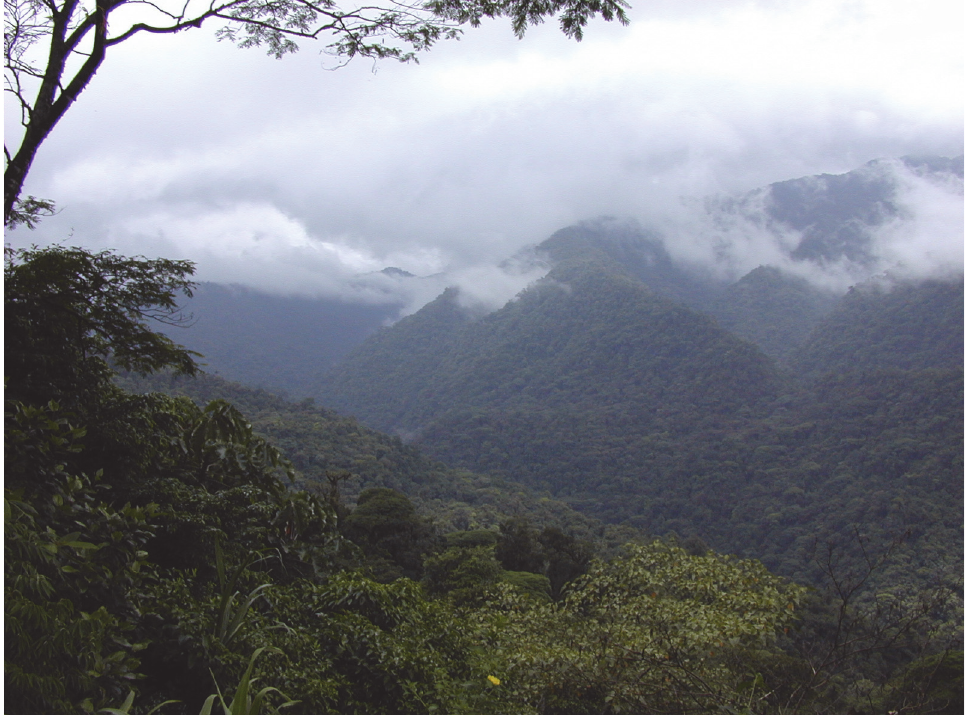
such as buttresses, using ladders if necessary, at a permanently marked point of measurement (POM). For multiple-stemmed individuals all stems with valid POMs were measured. The raw forest inventory data and litterfall data can be freely downloaded from the TEAM Project data portal: http://www.teamnetwork.org/data/query.